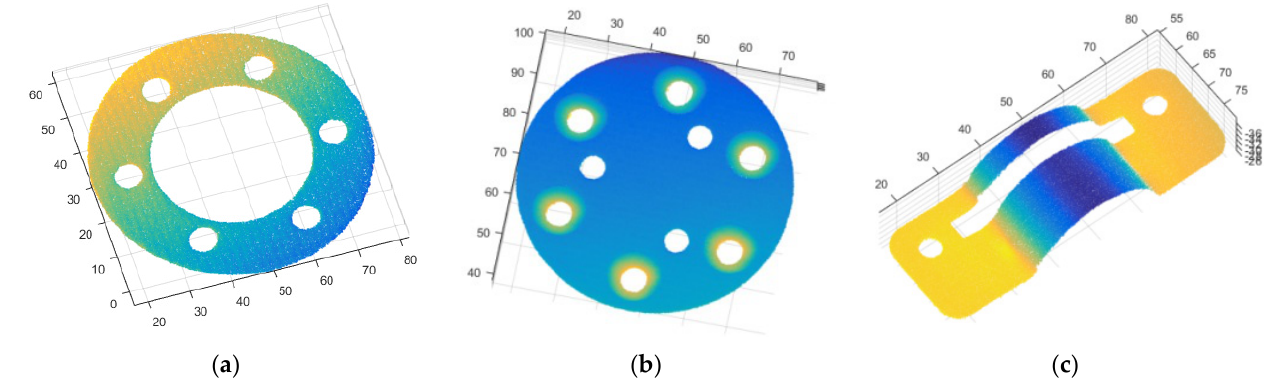
Figure 8. The 3D point cloud image measured by the method in this paper. The 3D point cloud of fl ange ( a ). The 3D point cloud of oil gasket ( b ). The 3D point cloud of U-card ( c